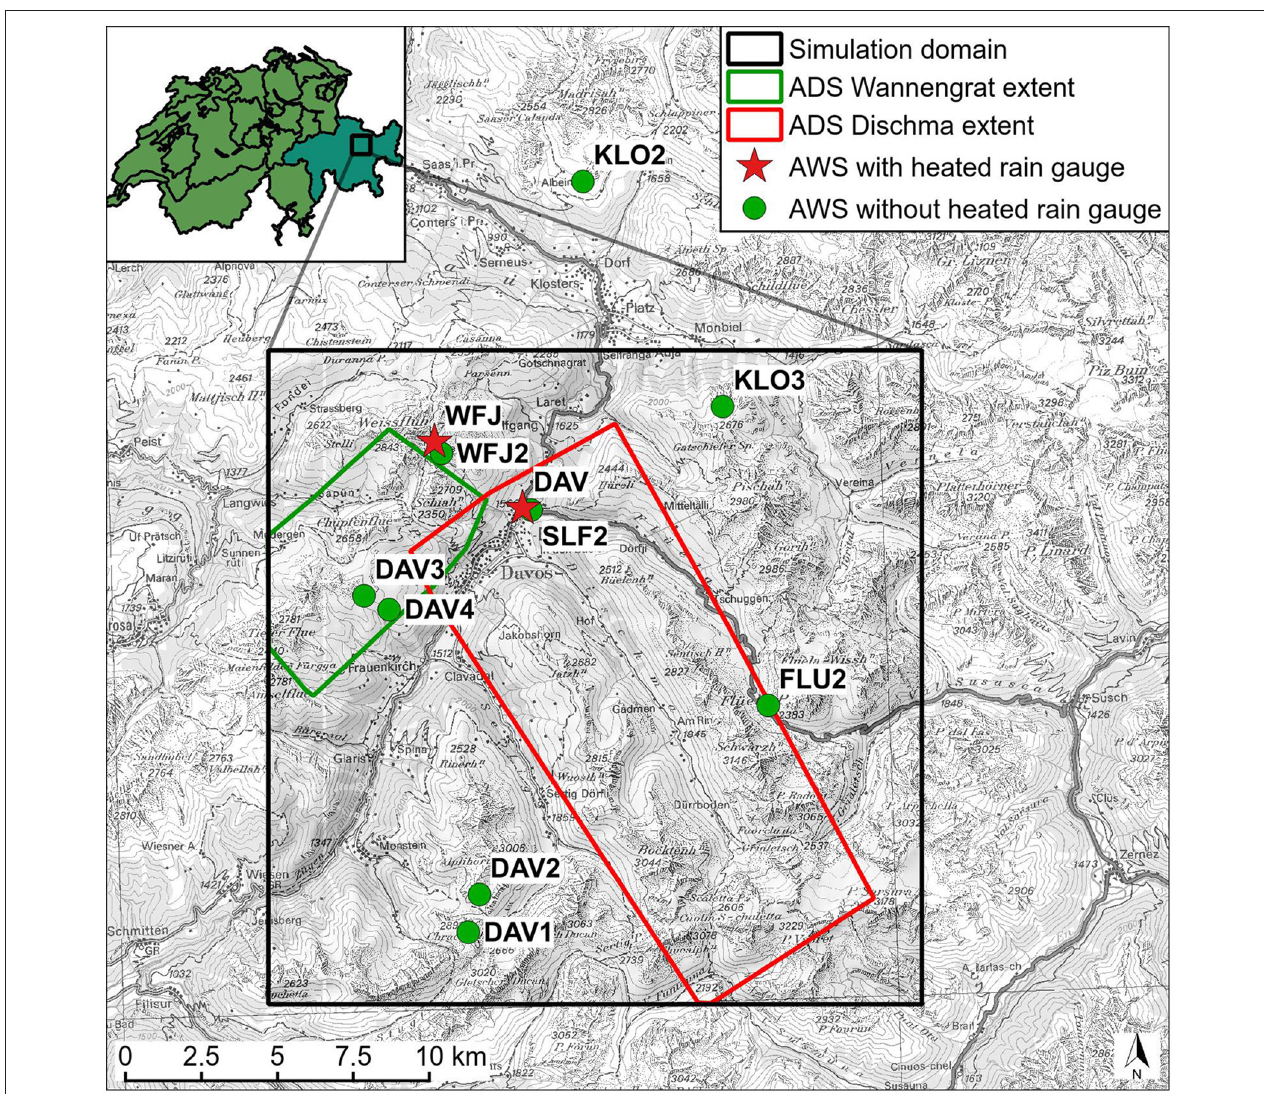
FIGURE 1 | Overview of the simulation domain in the area of Davos, Switzerland (black frame), the ADS (airborne digital sensor) Wannengrat extent (green frame) and the ADS Dischma extent (red frame). The AWSs used for Alpine3D input with (red stars) and without heated rain gauge (green dots). Maps reproduced by permission of swisstopo